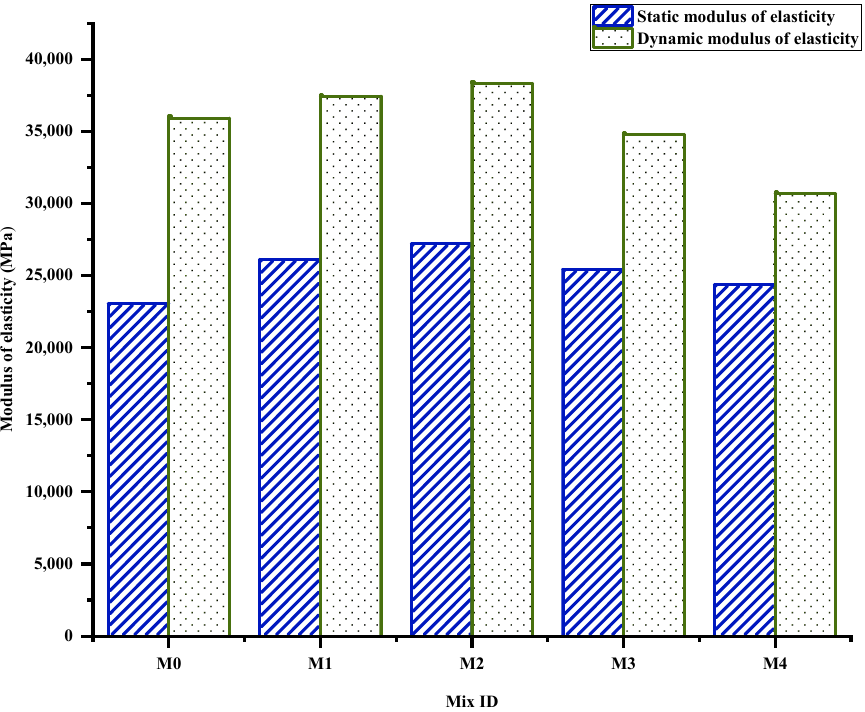
Figure 7. Comparison between static and dynamic modulus of elasticity of fine-grained cementitious composites for five different mixes.